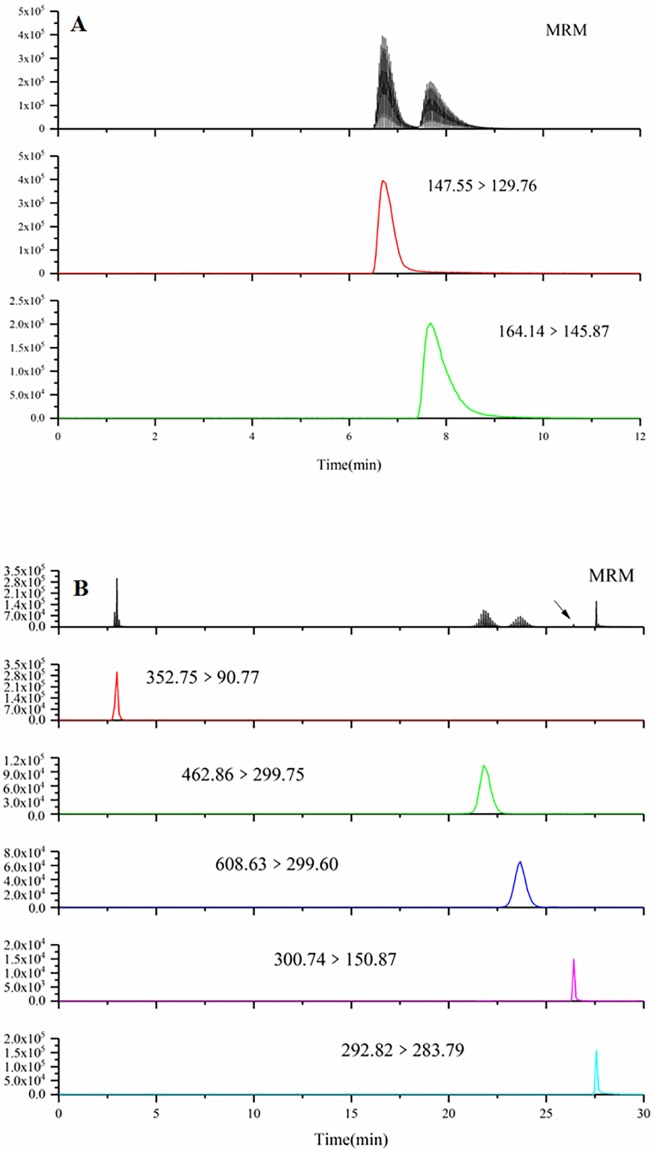
HPLC-ESI-MS/MS MRM chromatograms of alkaloid (A) and phenol compounds (B) identified in the samples.(TIF) (A) The red line represents the chromatogram of DNJ and the green line represents the chromatogram of fagomine. (B) The red, green, dark blue, pink, light blue line in represent the chromatograms of chlorogenic acid, isoquercitrin, rutin, quercetin and kaempferide, respectively.